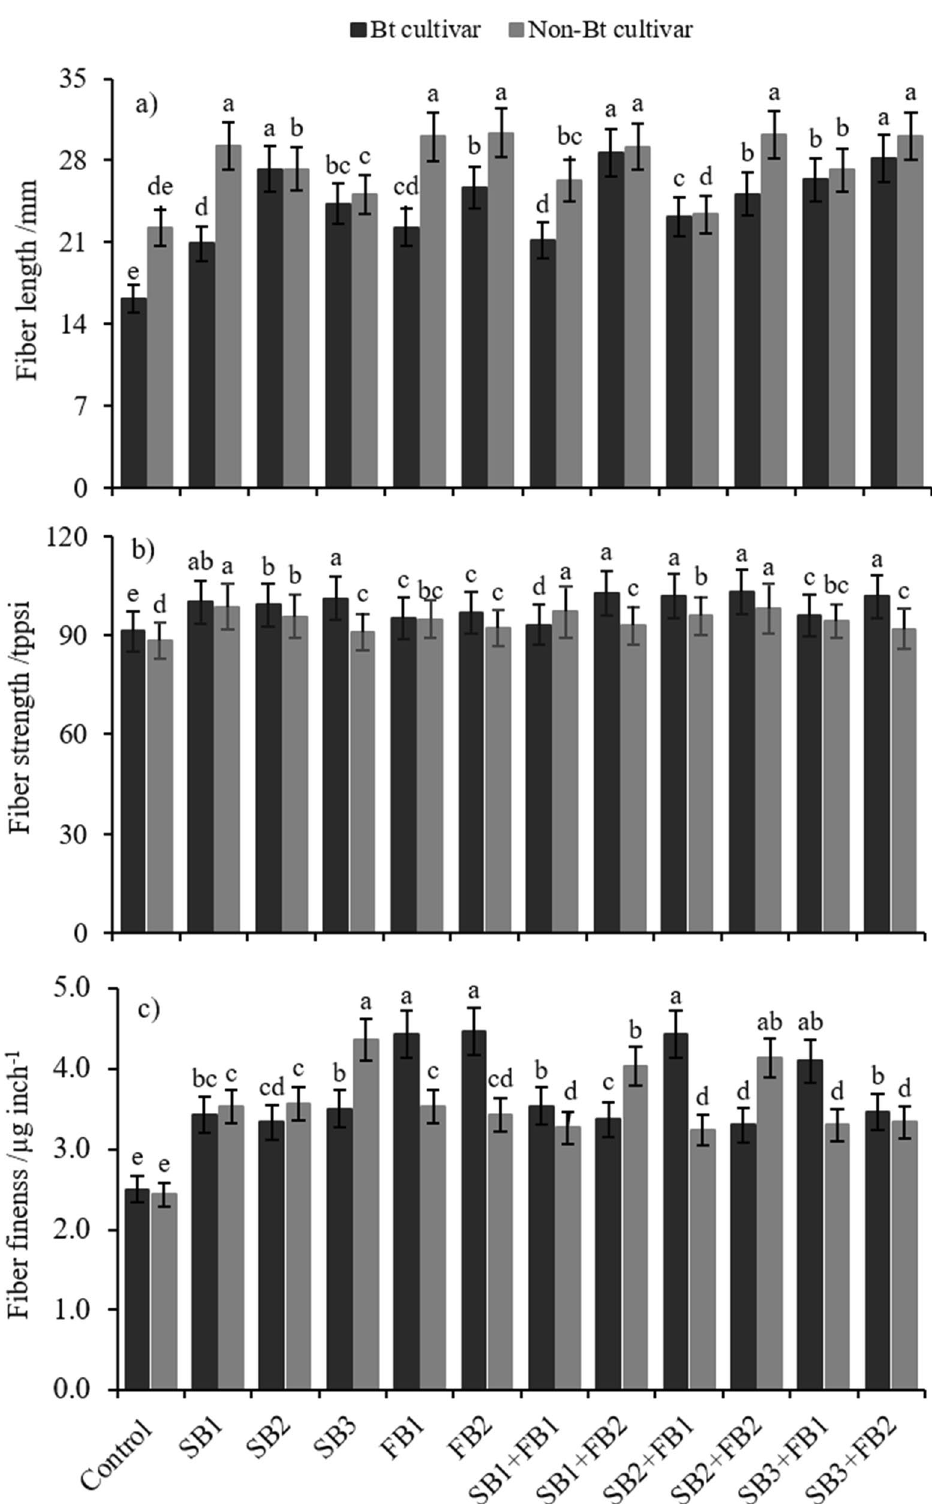
Fig. 3 Fiber quality characteristics of Bt and non-Bt cotton cultivars grown with different levels and methods of B